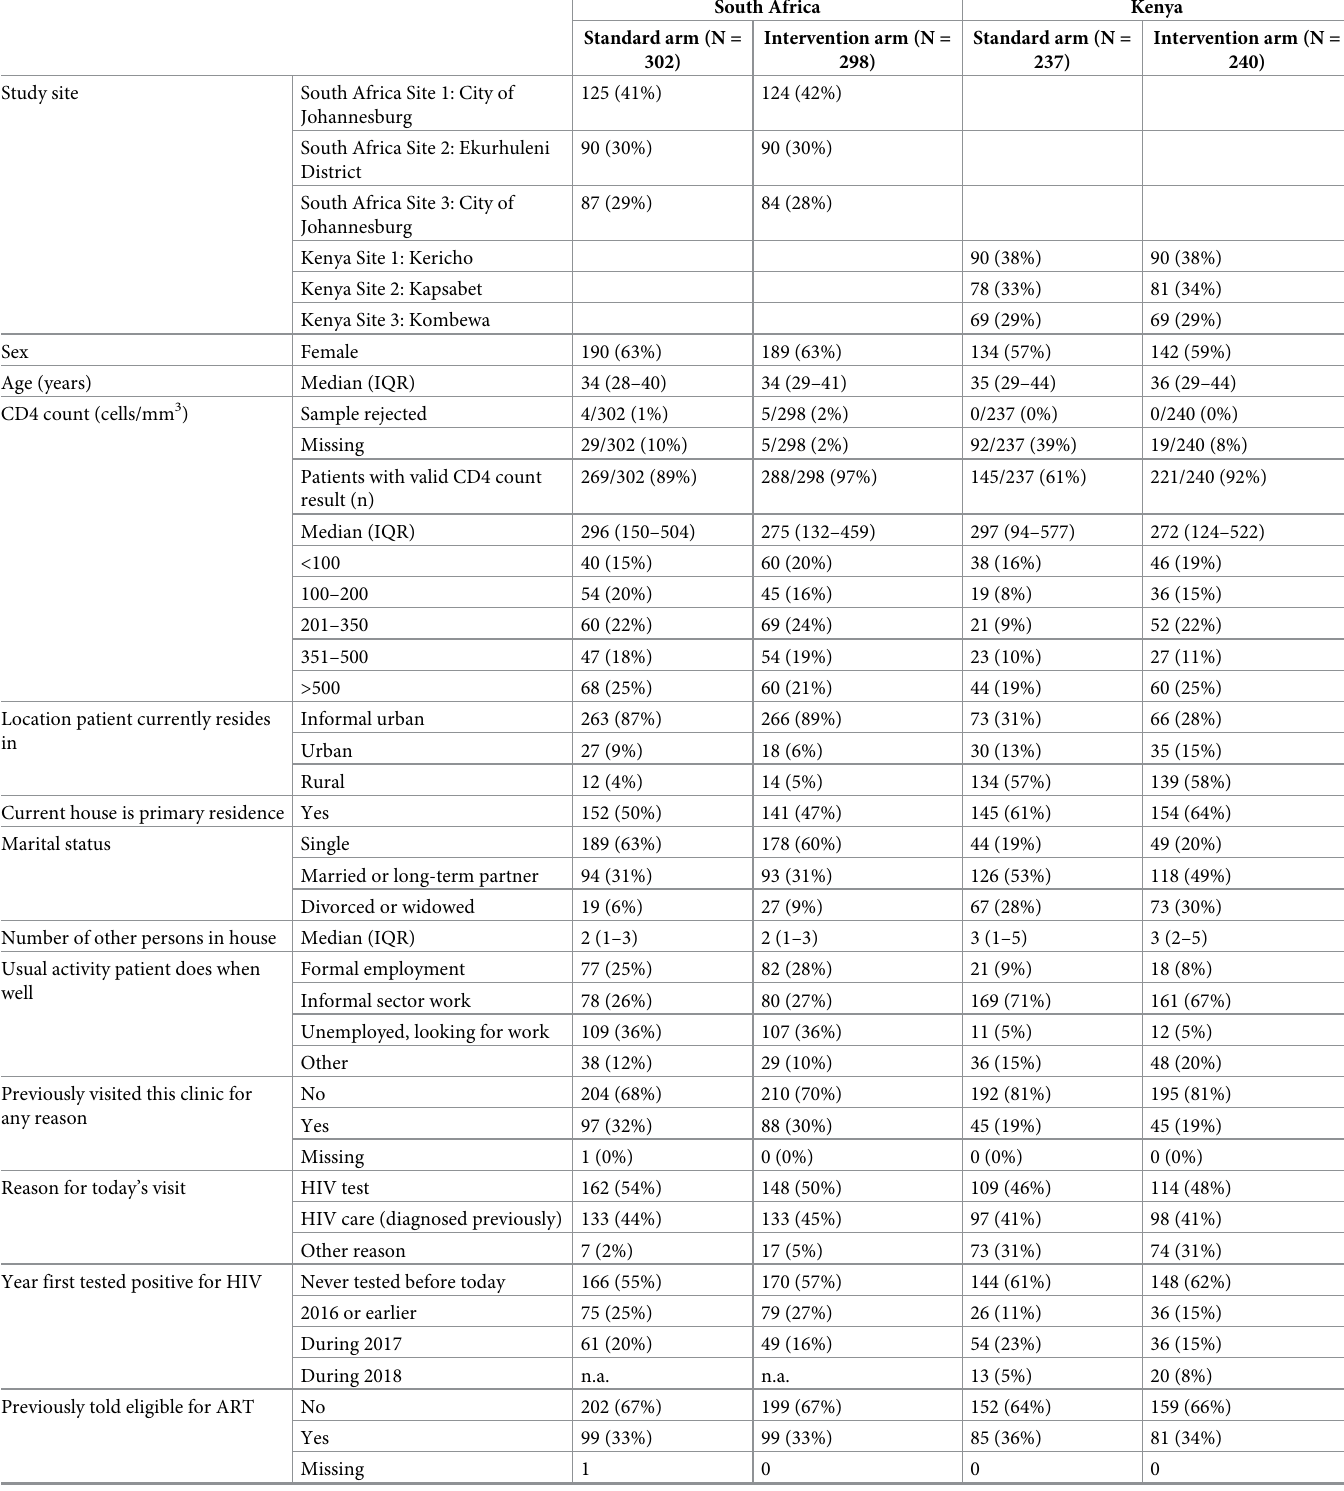
Table 1. Patient